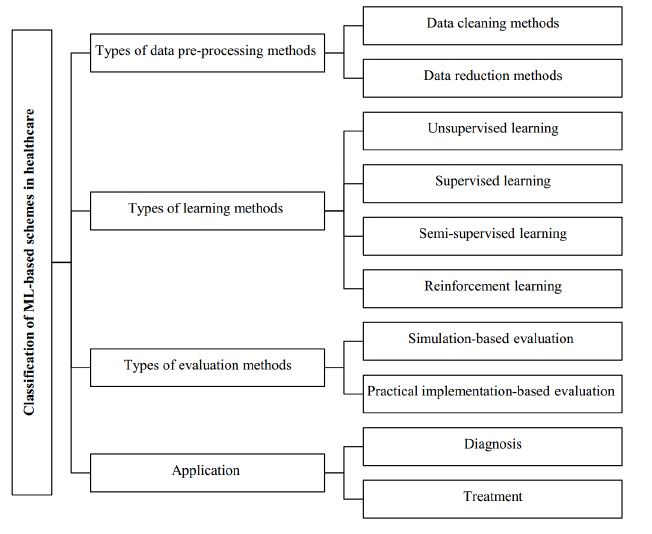
Figure 6. Our proposed classification of ML-based schemes in